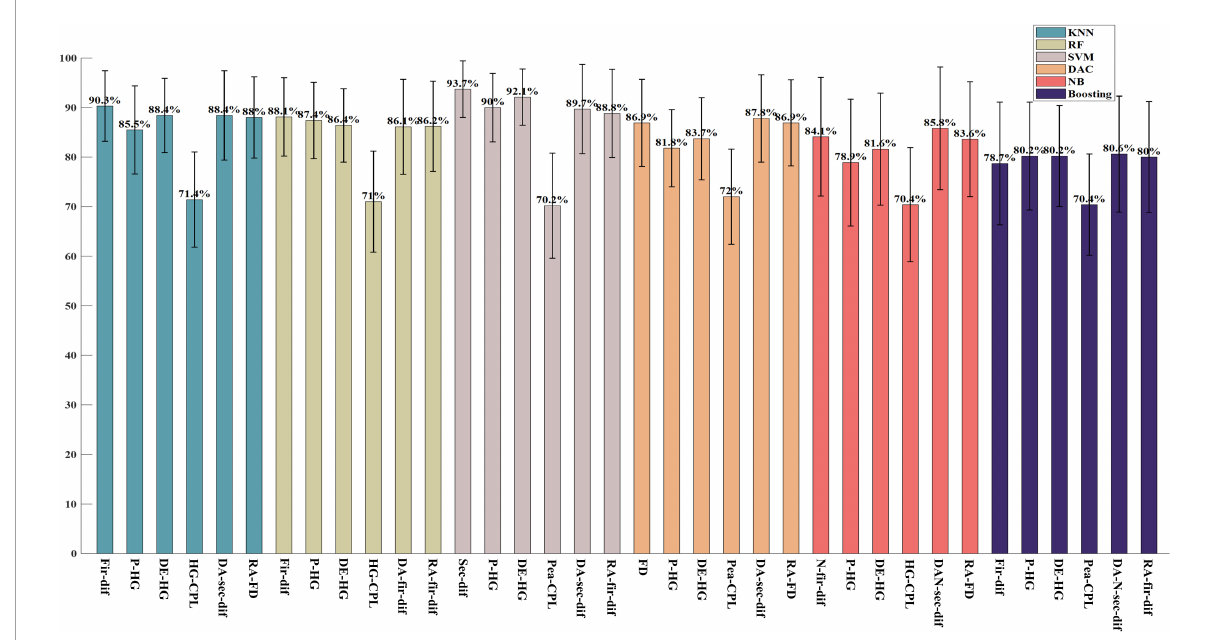
FIGURE1 The highest two-class classification accuracy in each feature domain on the ESD. The block which including six bars of same color is the results of same classifier and from left to right, it is the classification results by classifiers KNN, RF, SVM, DAC, NB, and Boosting, respectively.